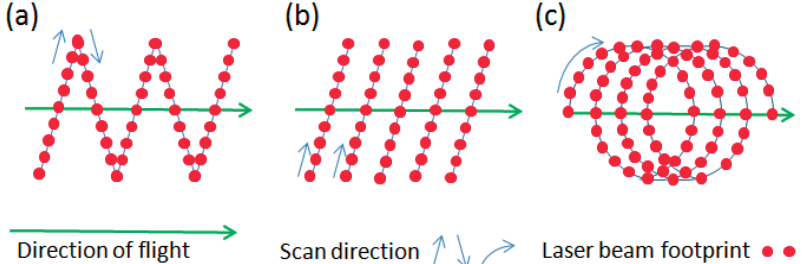
Figure 3. Single swath ground track patterns of different scanning